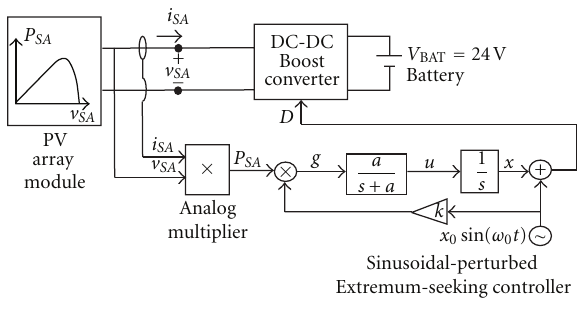
Figure 4: Proposed MPPT PV generator schema.